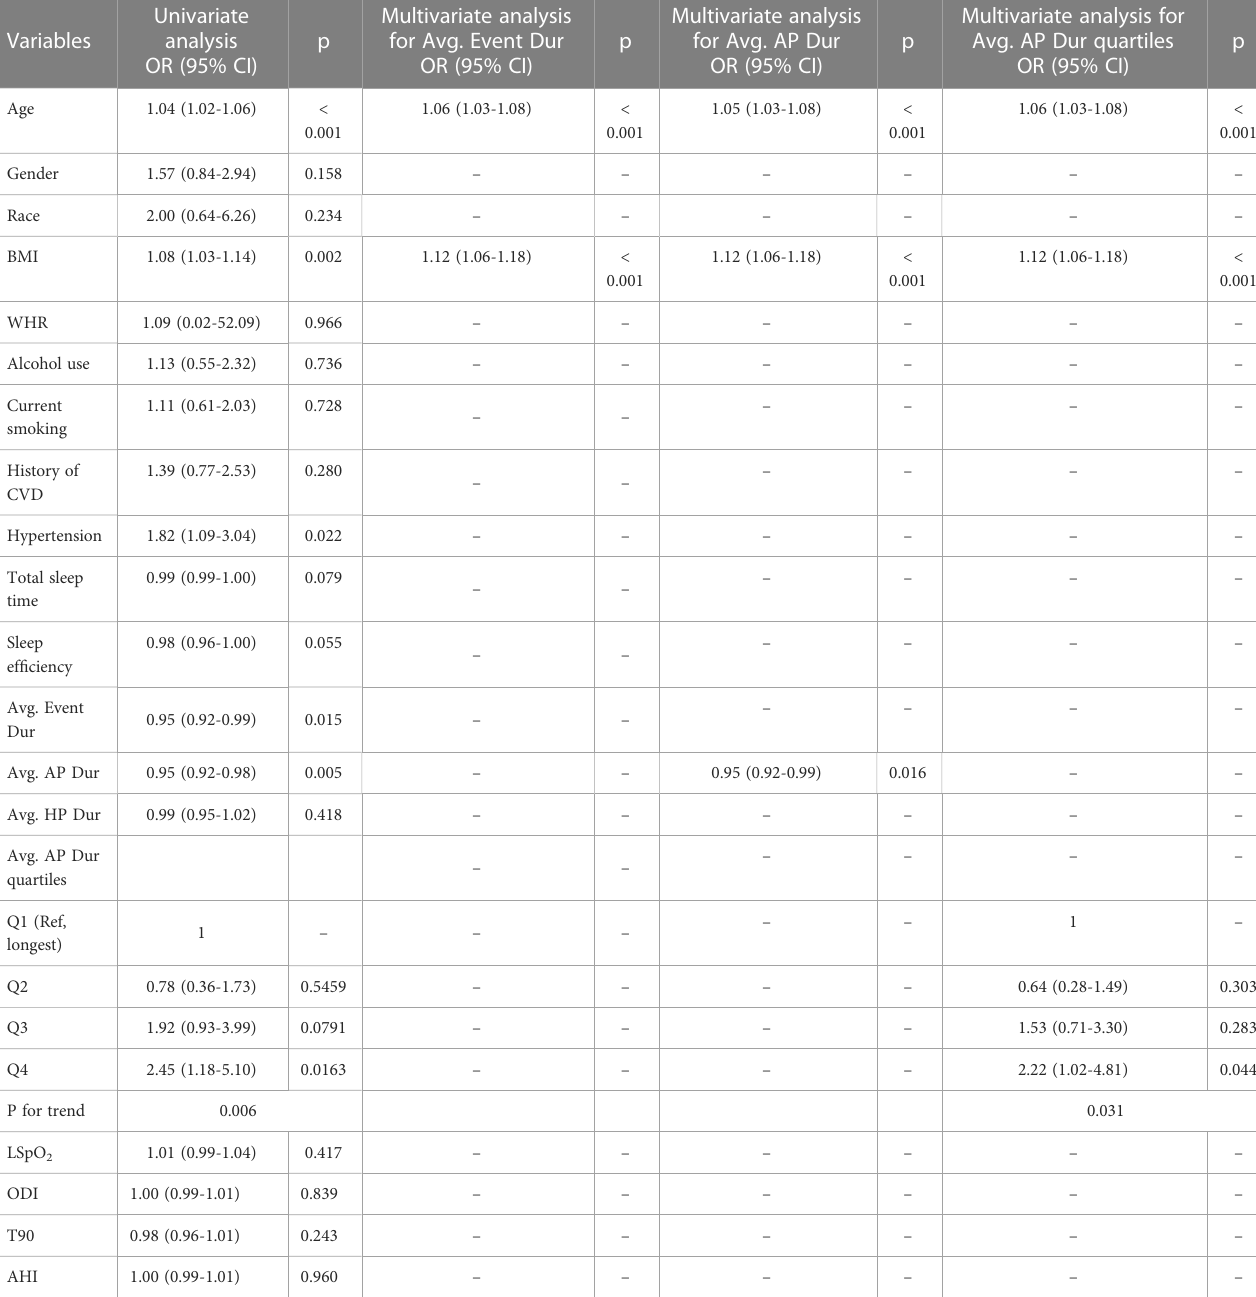
TABLE 2 Logistic regression analysis of average respiratory event duration and AHI with prevalence of diabetes.